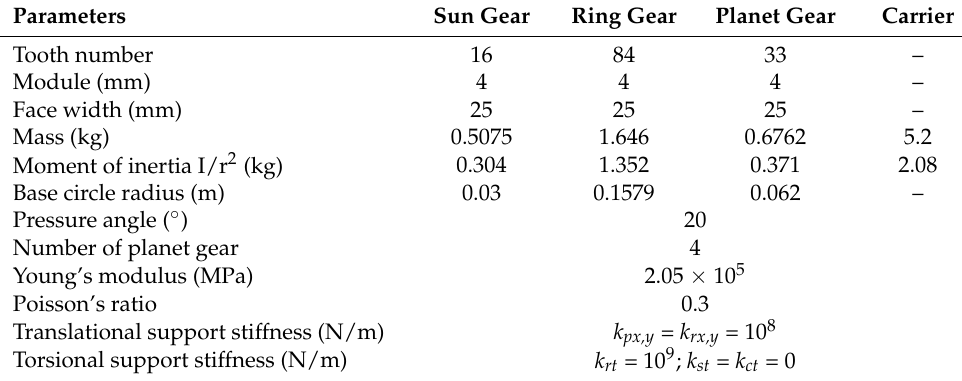
Table 1. Parameters of the spur PGS for simulation and experimentation.